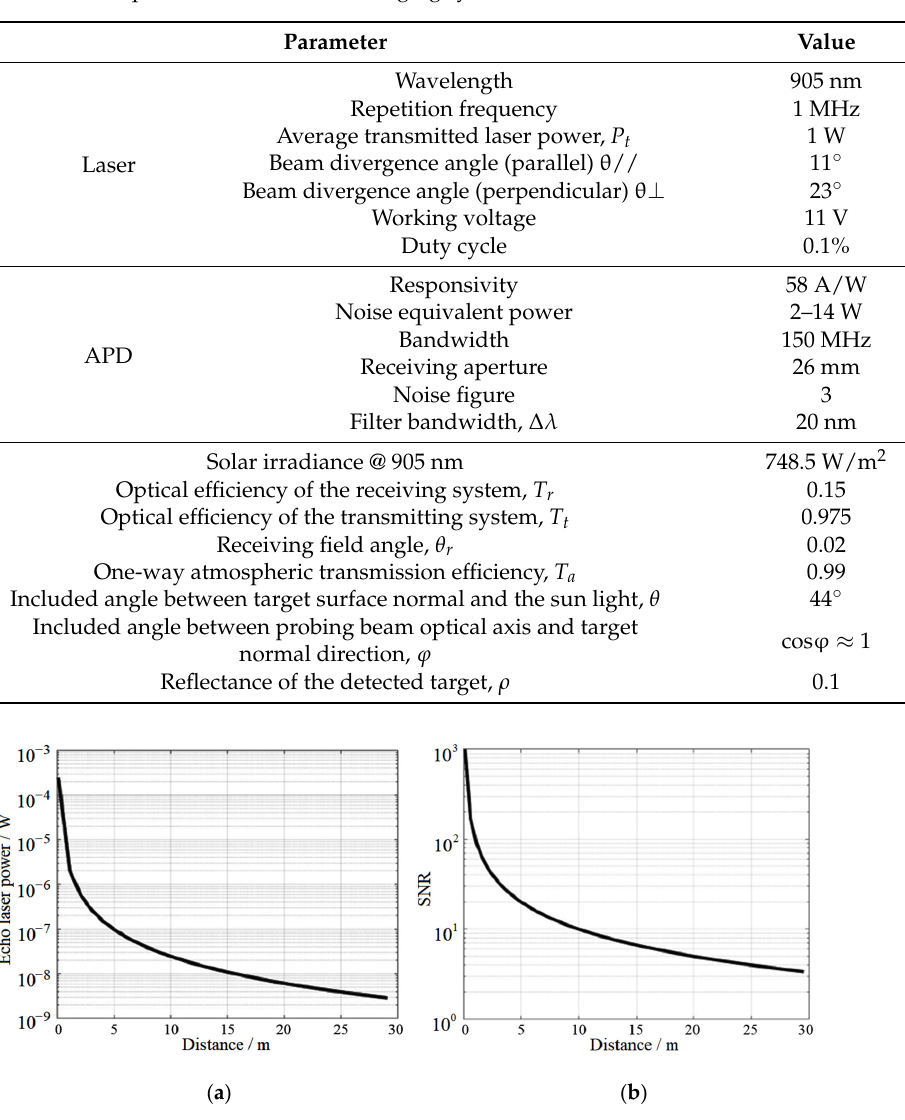
Table 1. Main parameters of the laser ranging system.